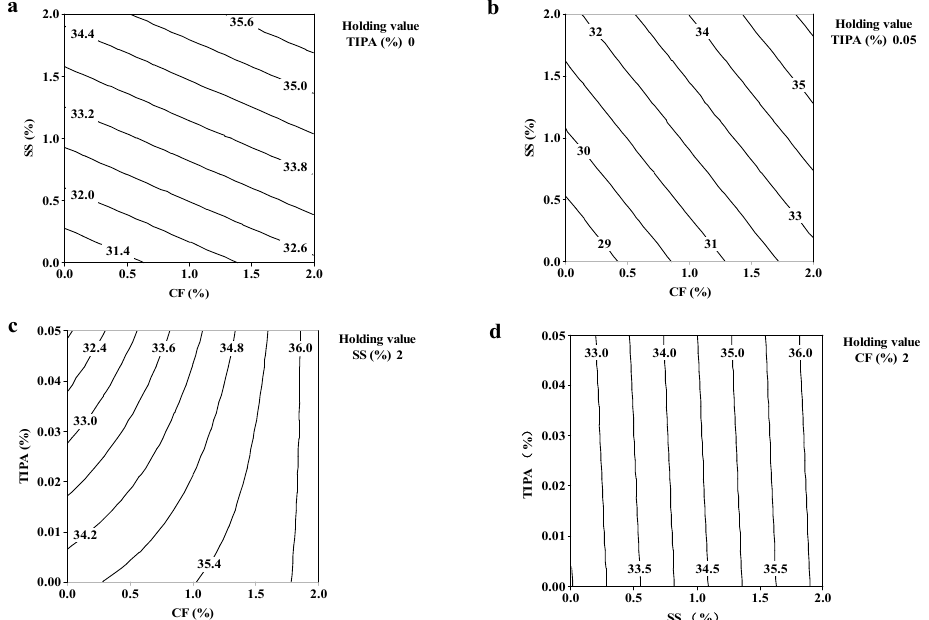
Figure 4. Effect of CF, TIPA and SS on the 3 d strength of cement mortars: ( a ) CF vs. SS (no TIPA), ( b ) CF vs. SS (0.05% TIPA), ( c ) CF vs. TIPA, ( d ) SS vs. TIPA.